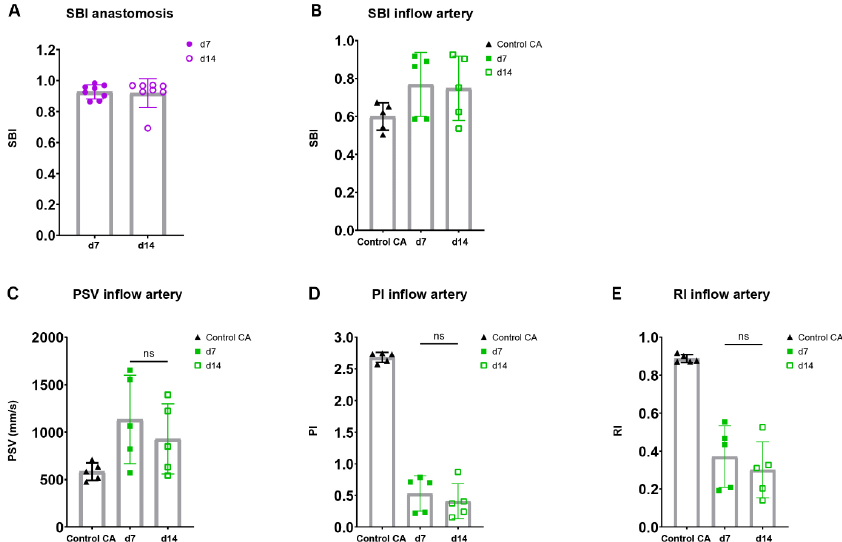
Figure 6. Flow pattern and velocity measurements in AVFs in C57BL/6J mice over time. SBI at the anastomosis ( A ) and inflow artery ( B ) site in AVFs of C57BL/6J mice at 7 and 14 days post-surgery. PSV ( C ), PI ( D ), RI ( E ) in control carotid arteries (n = 5) and AVFs (n = 5) in C57BL/6J mice after 7 and 14 days post-surgery. Statistics AVF over time: paired t -test.